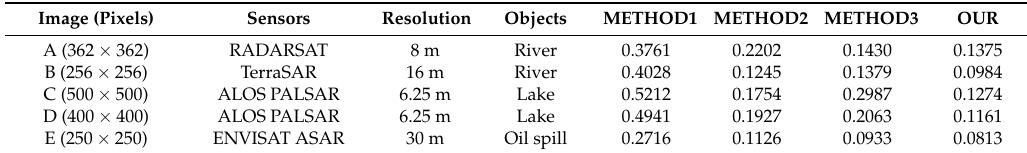
Table 2. Comparison of region fitting error (RFE) scores for METHOD1, METHOD2, METHOD3 and our